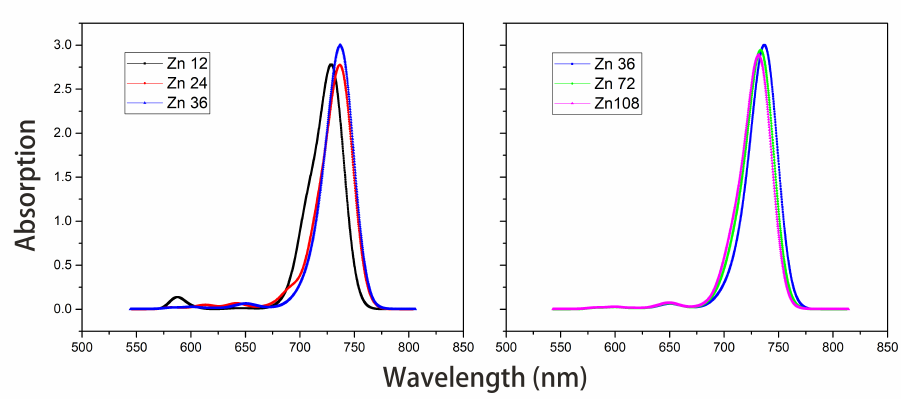
Figure 9. Absorption spectra of model Zn12/24/36 and model Zn36/72/108 with the SMD solvent